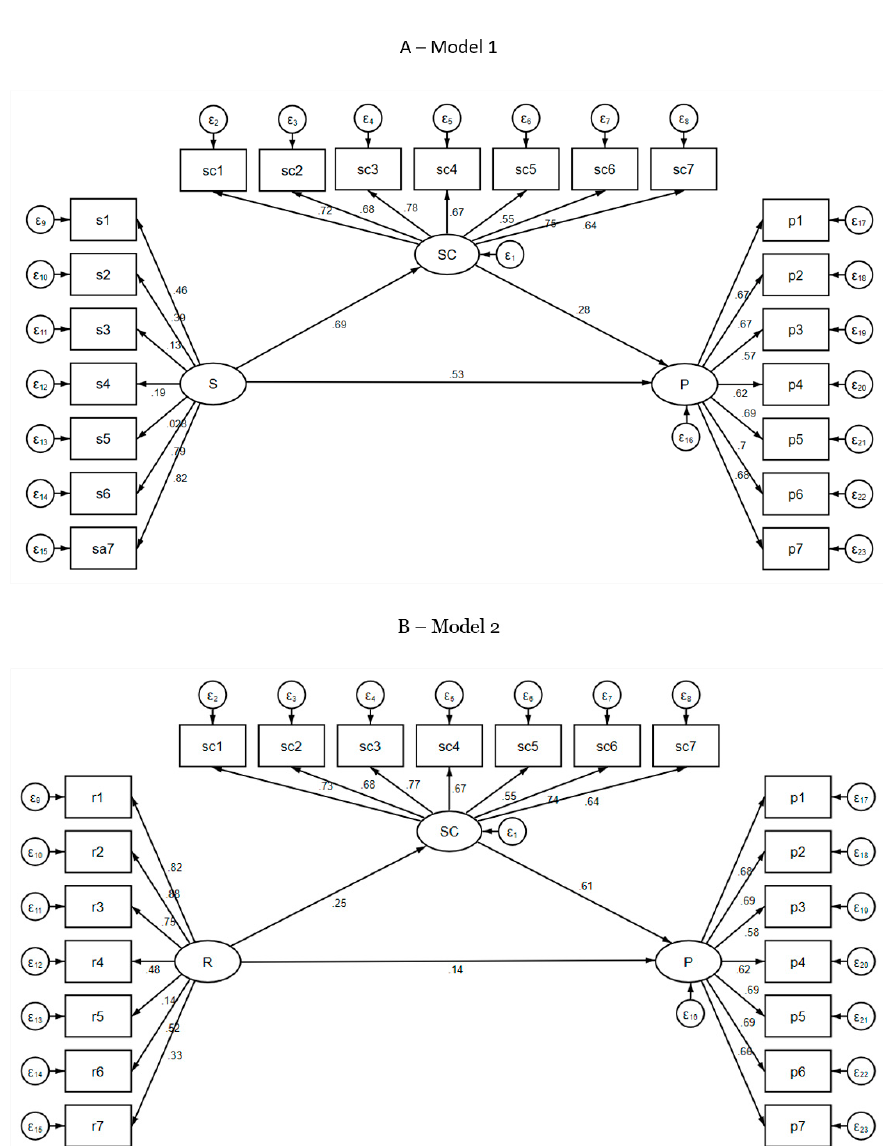
Figure A1. Representations of Model 1 and Model 2.